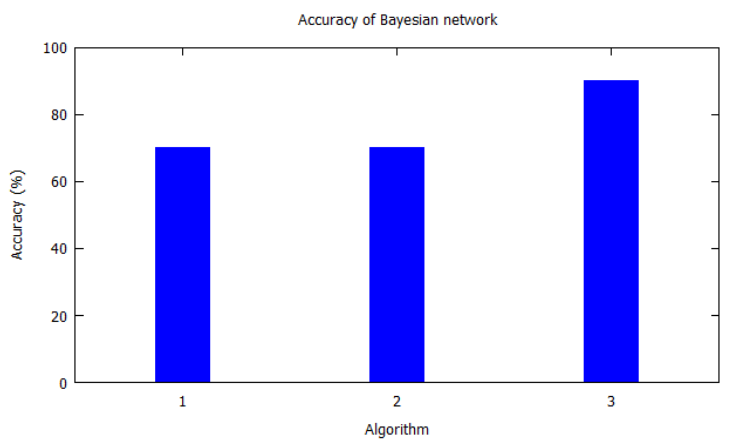
Figure 5. Accuracy of Bayesian network. Bayesian network from Table 5 is shown with X -axis depicting the algorithms the paper used, i.e., the serial number from Table 5. Y -axis shows the accuracy of the algorithm that was used by the authors for that study.